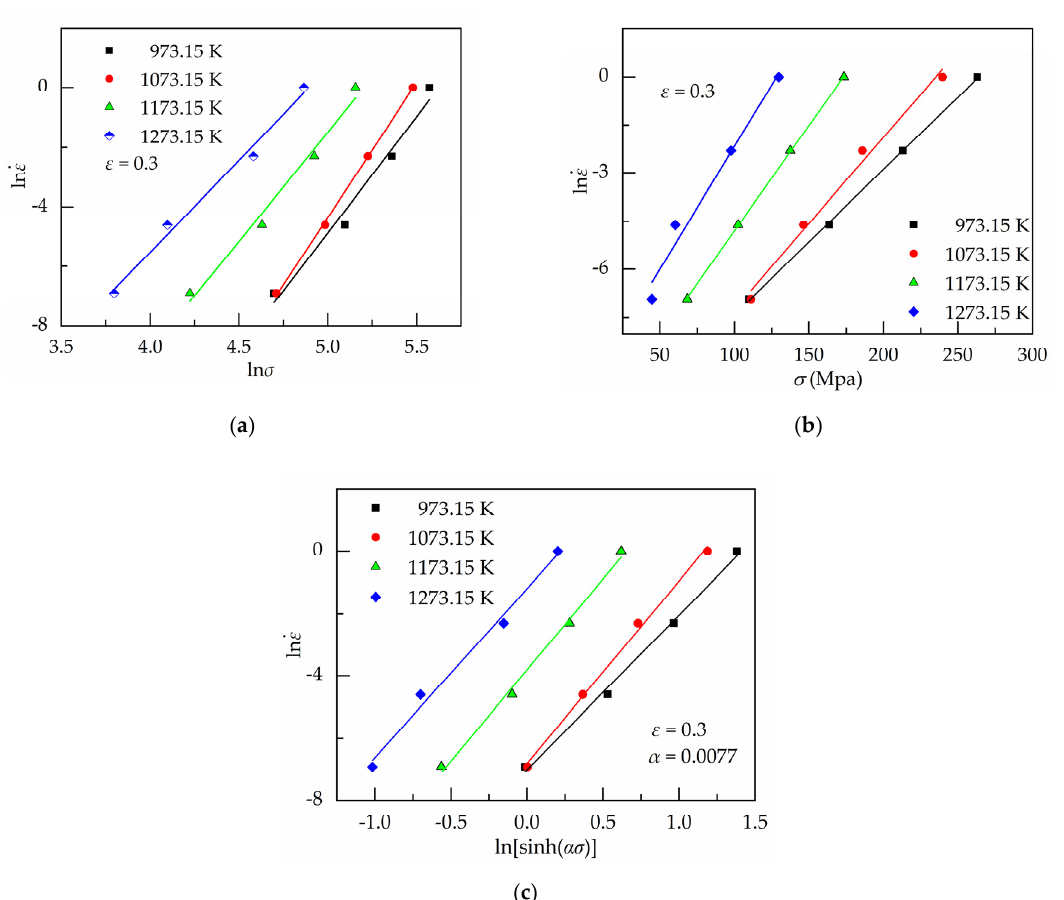
Figure 4. Relationships between ( a ) ln σ and ln 𝜀(cid:4662) ; ( b ) σ and ln 𝜀(cid:4662) ; ( c ) ln[sinh( ασ )] and ln 𝜀(cid:4662) .